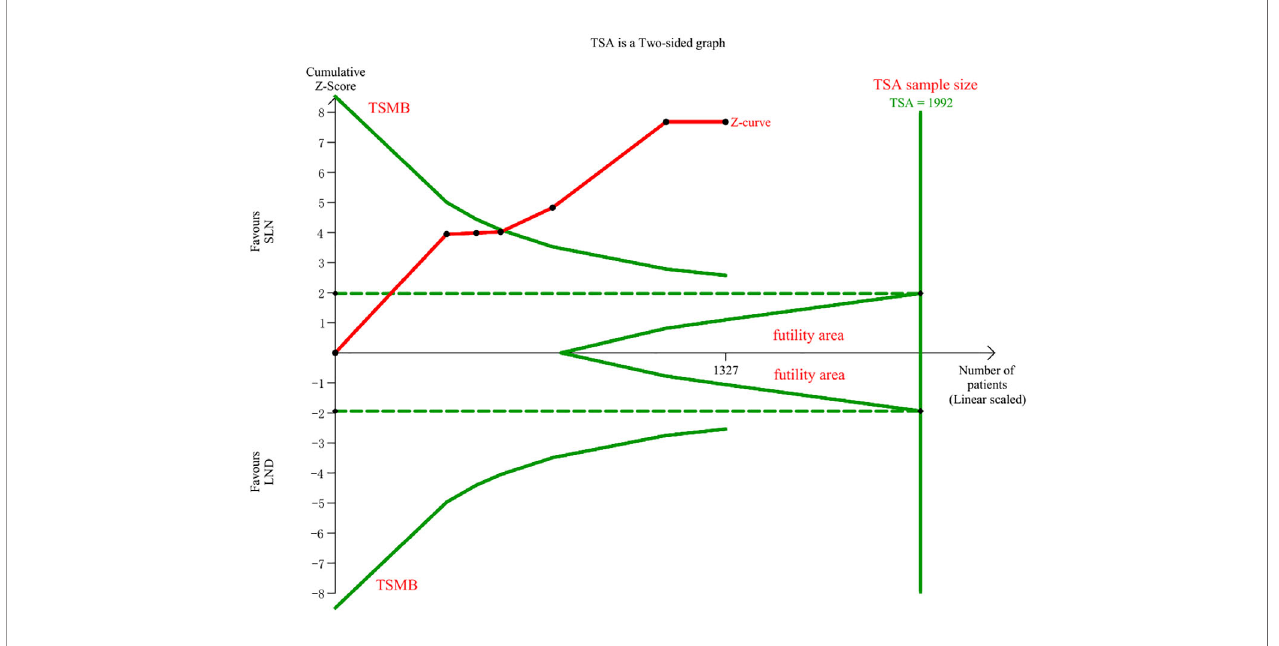
FIGURE 3 | TSA of blood loss, a = 0.05, b = 0.8, two-sided